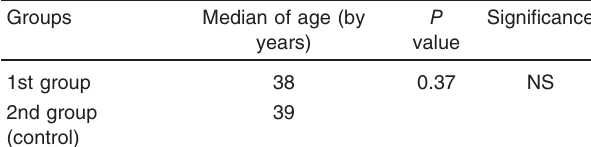
Table 1 Comparison between the first group (those who received voice hygiene advices) and the control group according to the median age Groups